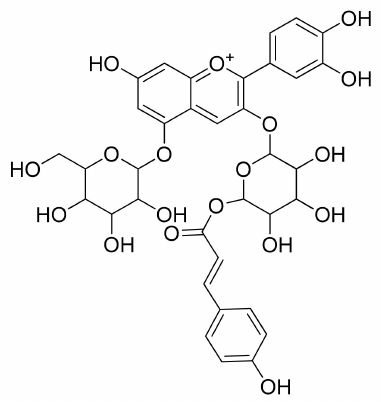
Figure 11. The extracted anthocyanin monomer from Lycium ruthenicum Murray namely petu- nidin 3-O-[6-O-(4-O-(trans-p-coumaroyl)- α -l-rhamnopyranosyl)- β -d-glucopyranoside]-5-O-[ β -d-